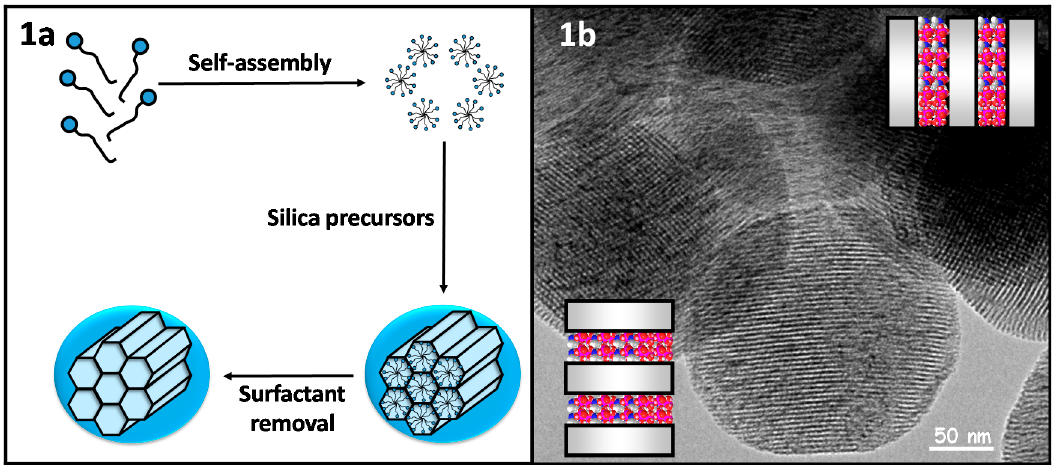
Figure 1. ( a ) Scheme synthesis of mesoporous silica nanoparticles through a modified Stöber; ( b ) Transmission Electron Microscopy micrography of the pore distribution of MCM-41-type mesoporous silica nanoparticles.